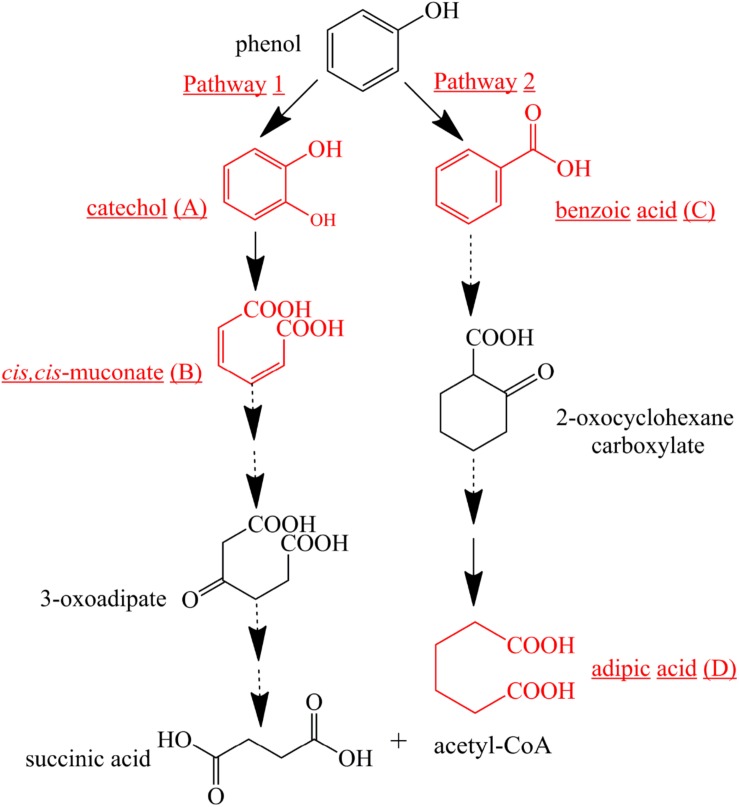
Proposed pathways for phenol degradation by the strain SASS1. The solid line shows the observed degradation pathway, and the dashed line shows the predicted pathways from previous studies (Hoyos-Hernandez et al., 2014; Nesvera et al., 2015).